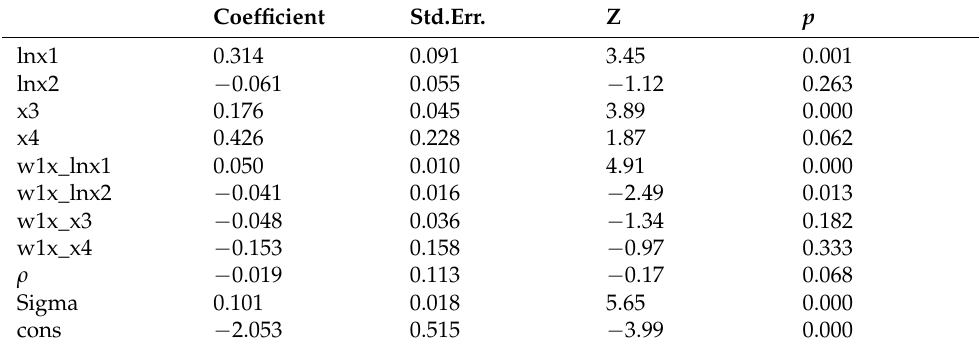
Table 5. Unit root